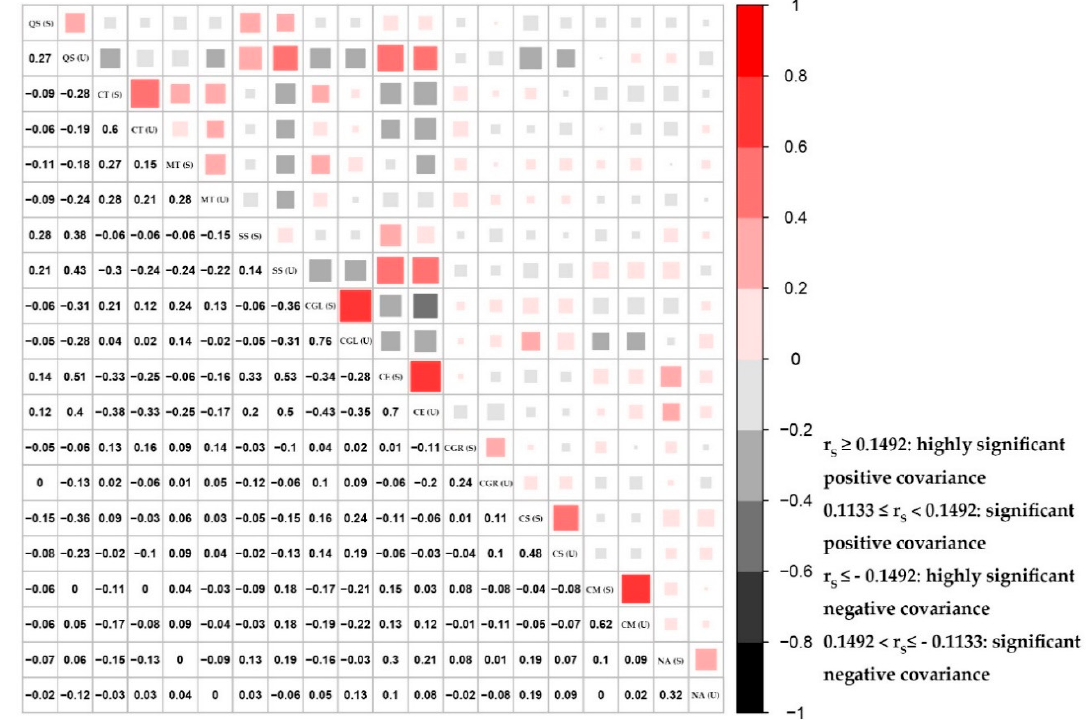
Figure 5. Correlation matrix of the Spearman’s rank correlation coefficient (SRCC) of the dominant species in the old-growth forest.